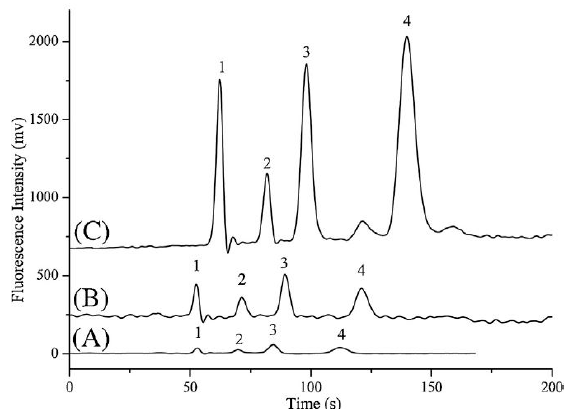
Figure 11. Signal enhancement of the multiple concentration: ( A ) signal intensity without concentration. The running bu ff er was 90 mM borate solution at pH 9.4 and the sample was diluted with the running bu ff er solution. The sample injection time was 2 s. ( B ) Signal intensity with FASS. The sample was prepared in a 10-fold diluted running bu ff er and the sample injection time was 2 s. ( C ) Signal intensity with a combination of FASS and reversed–filed stacking. The sample injection time was 10 s and the reversed polarity time was 8 s. The concentrations of 5-HT, DA and NE in ( A ) were 0.4, 0.6 and 0.7 µ M, respectively. The sample concentrations in ( B ) and ( C ) were 1 / 10 of that in ( A ). Peak identification: 1, the excess of Cy5; 2, 5-HT; 3, DA; and 4, NE. Figure adopted from reference [99] with the copyright permission.